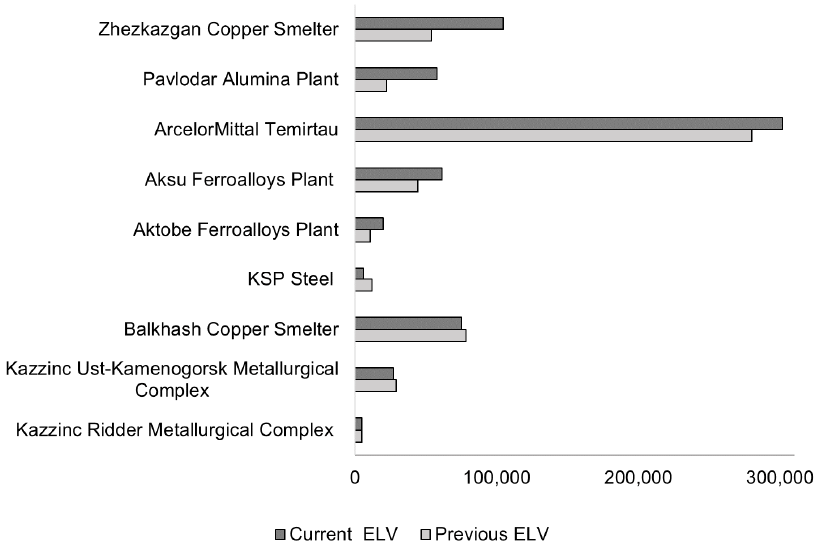
Figure 8. Changes in the emission limit values (ELVs) of the metallurgical enterprises, tons. Data source: Emissions permitting documents of the enterprises.